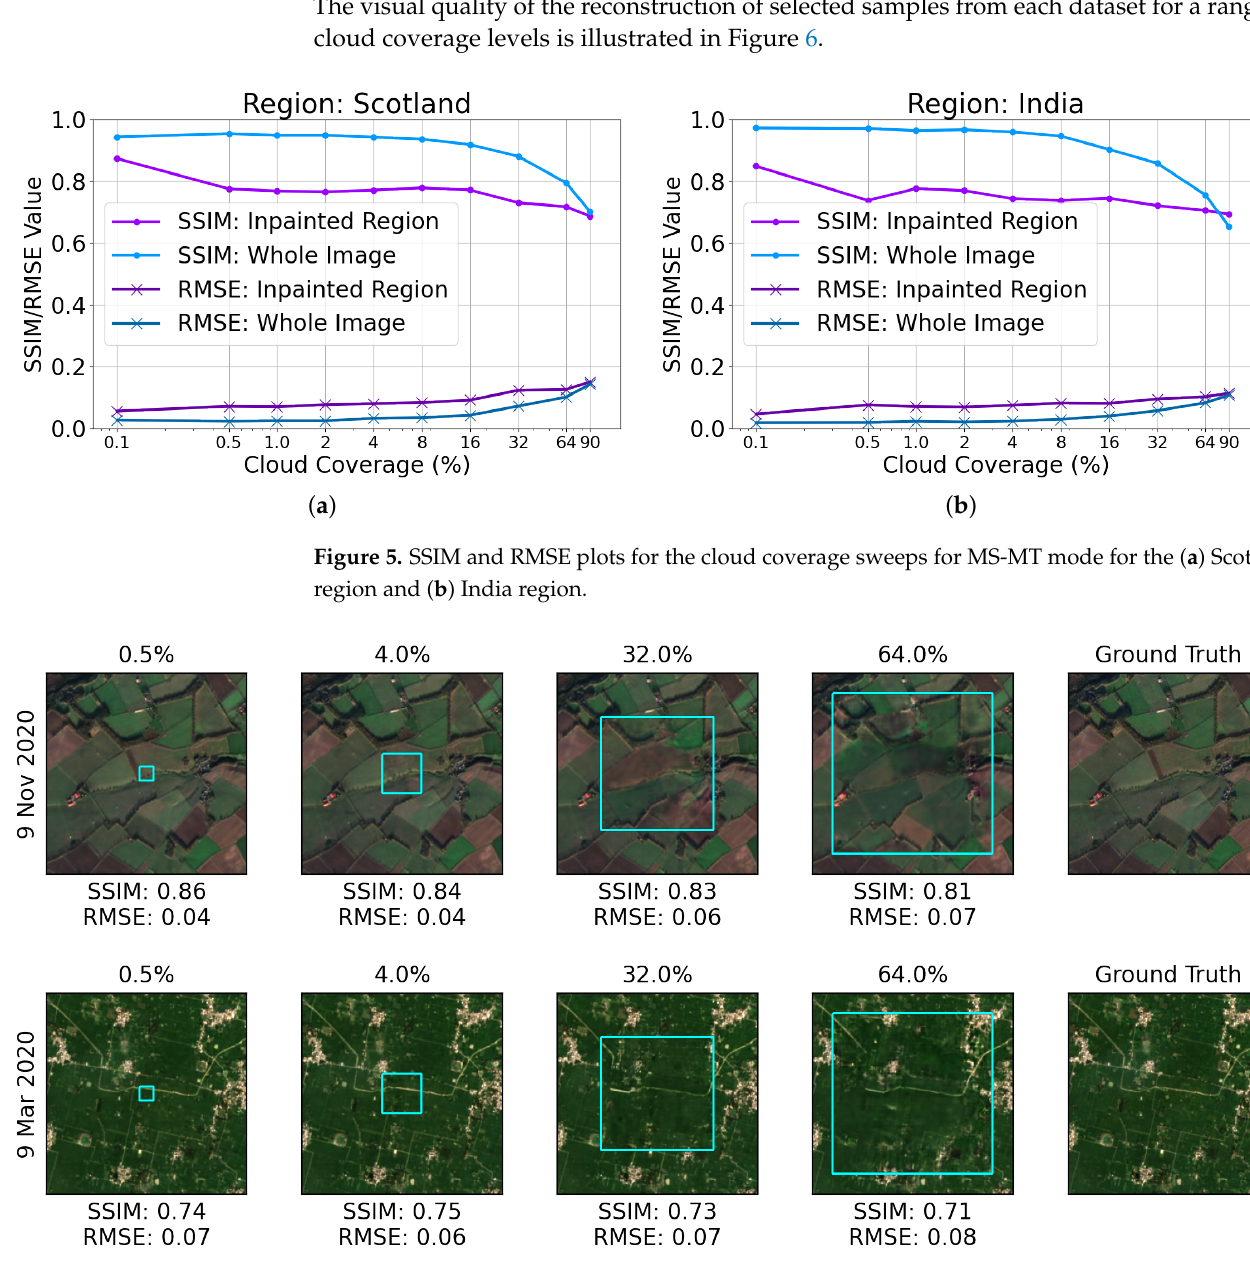
Figure 6. Samples of images reconstructed in the cloud coverage sweep procedure (ranging from 0.5% to 64.0% cloud cover) for MS-MT mode in Scotland ( top row ) and India ( bottom row ). The SSIM and RMSE metric values are shown for the inpainted